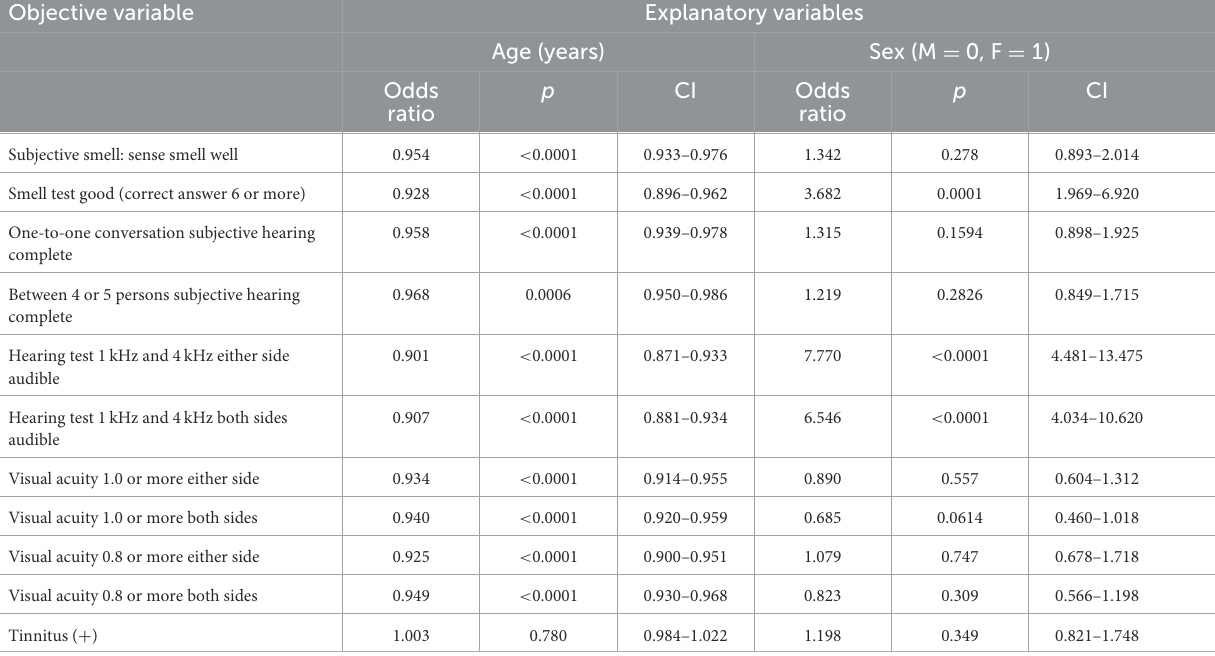
TABLE 2 Influence of age and sex on subjective smell, smell test, subjective hearing, hearing test, visual acuity and tinnitus (logistic regression analysis).